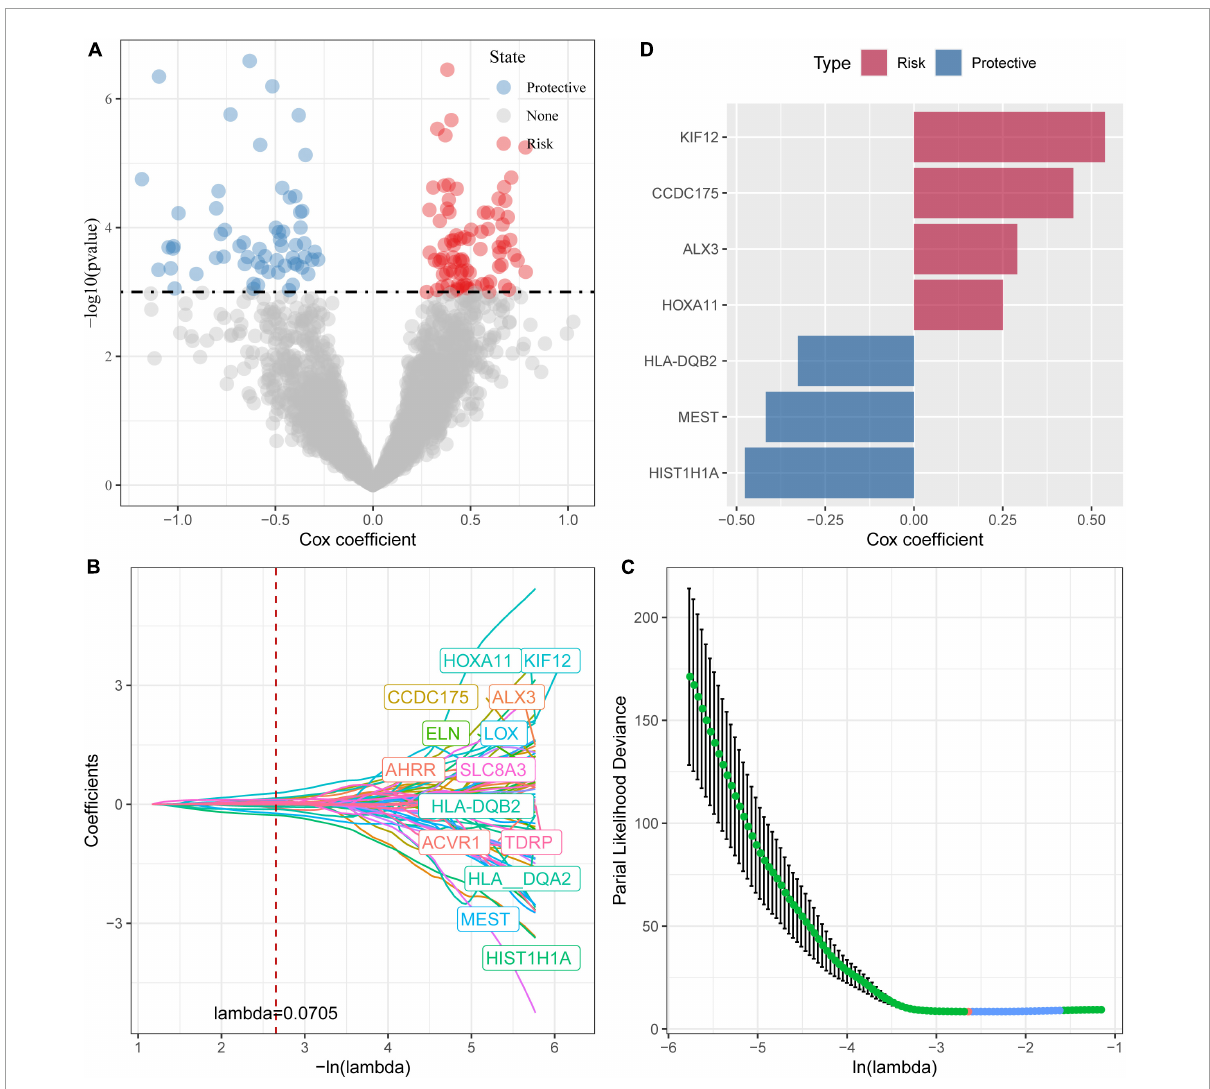
FIGURE4 Identification of prognostic genes. (A) A total of 961 promising candidates were identified among the DEGs; (B) The trajectory-based change of each independent variable with lambda; (C) The optimal λ selection by cross-validated deviance of LASSO fit; (D) Multivariate cox analysis and the coefficients of prognosis-related